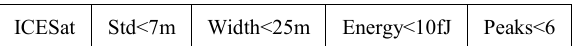
Table 2: Criteria used for ICESat data filtering